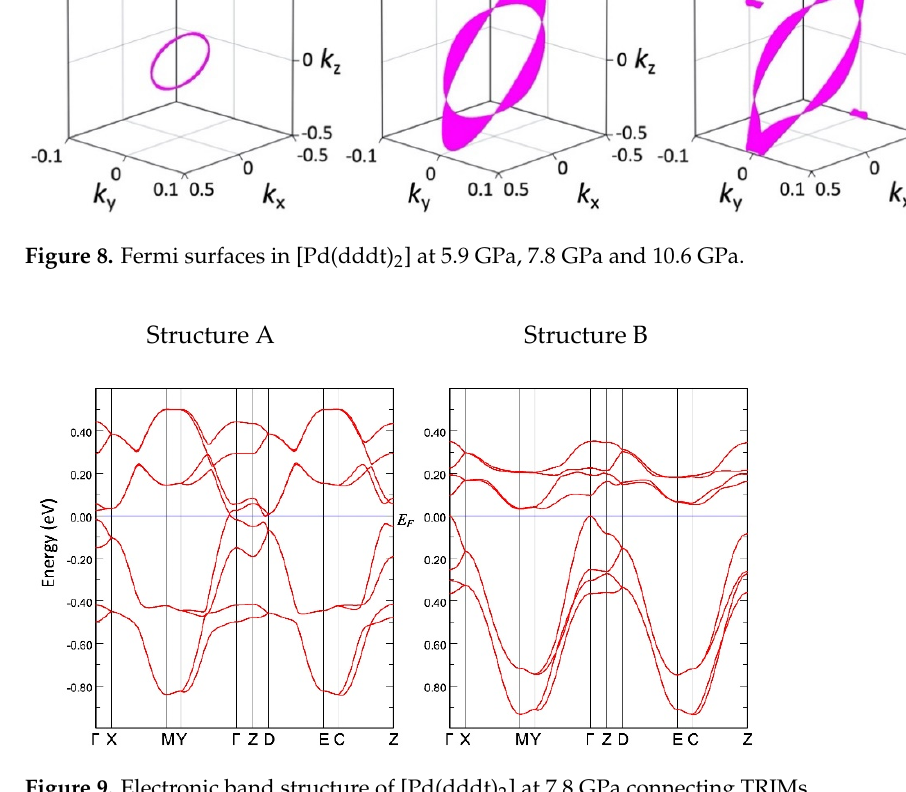
Figure 9. Electronic band structure of [Pd(dddt) 2 ] at 7.8 GPa connecting TRIMs.